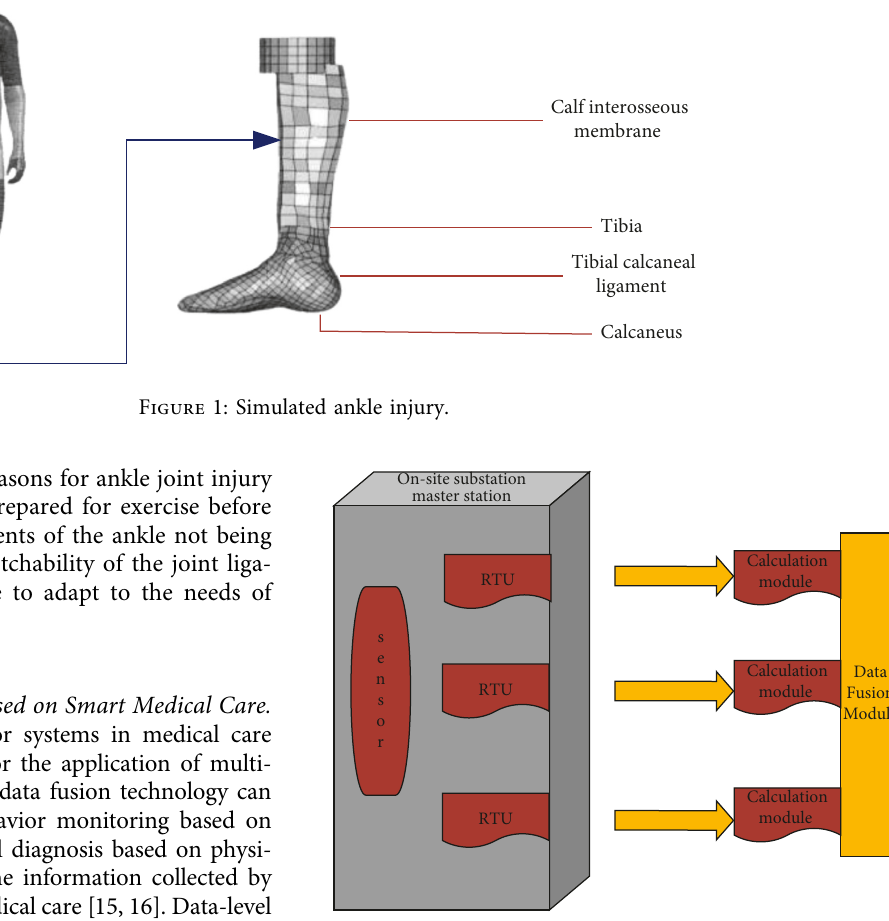
Figure 2: The structure of multisource data